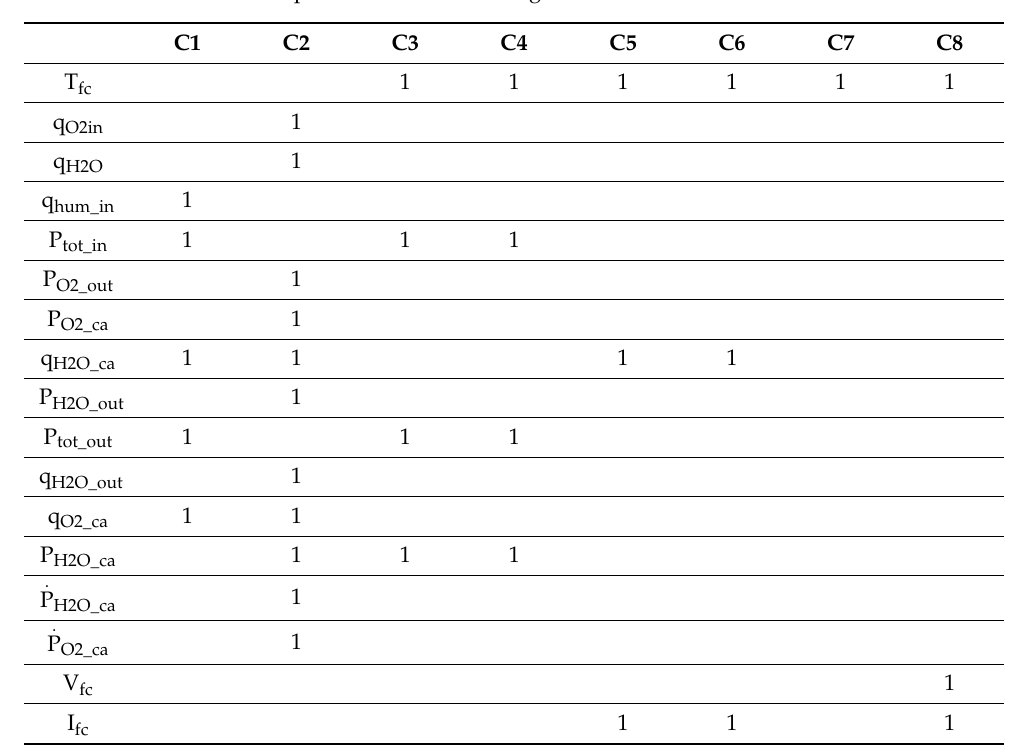
Table 2. Incidence matrix updated with the flooding